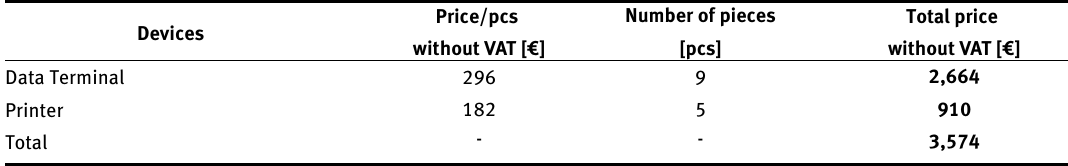
Table 4: Gama manufacturer devices and their parameters